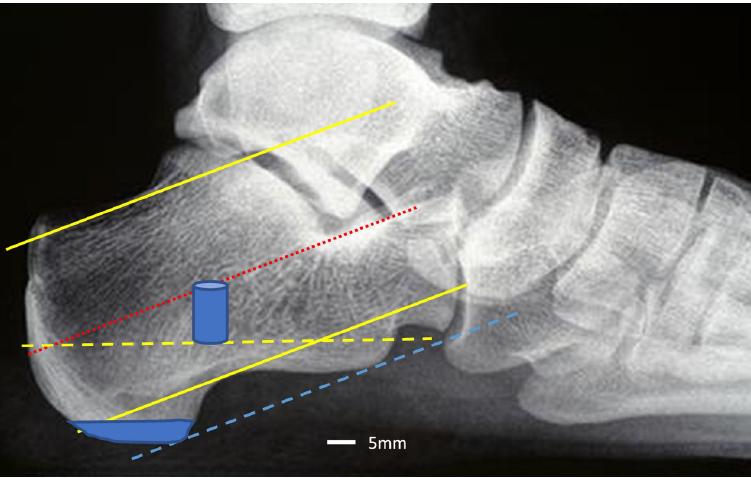
Fig 1. Location of mid-calcaneal and plantar ROI. Mid-calcaneal (cylinder) and plantar ROIs are shaded.